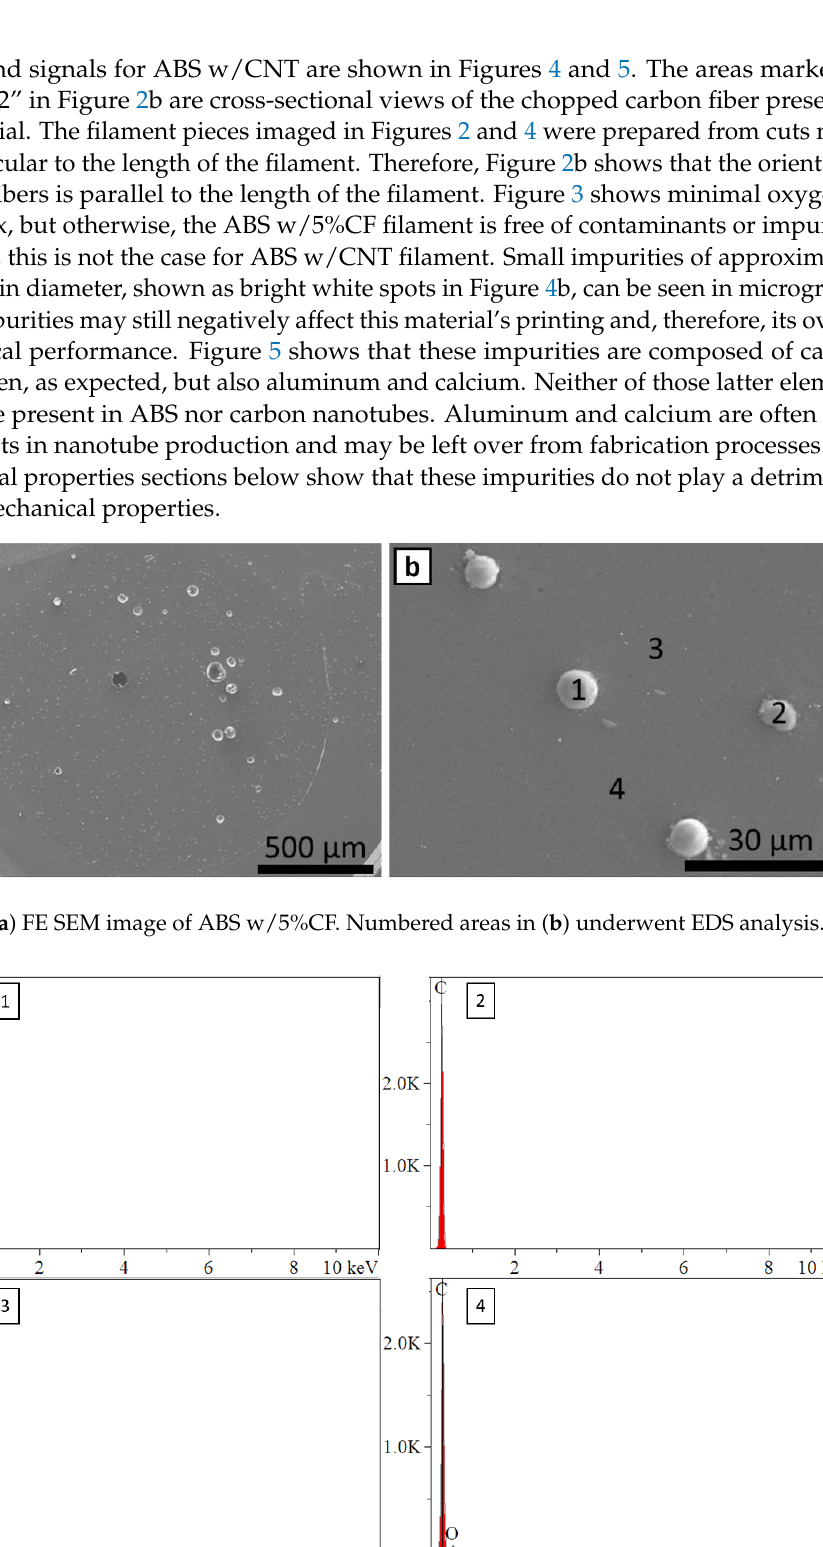
Figure 4. ( a ) FE SEM image of ABS w/CNT. Numbered areas in ( b ) underwent EDS analysis. Figure 5. EDS spectra of ABS w/CNT showing presence of impurities. Numbers 1 and 2 correspond to the respective areas in Figure 4b.